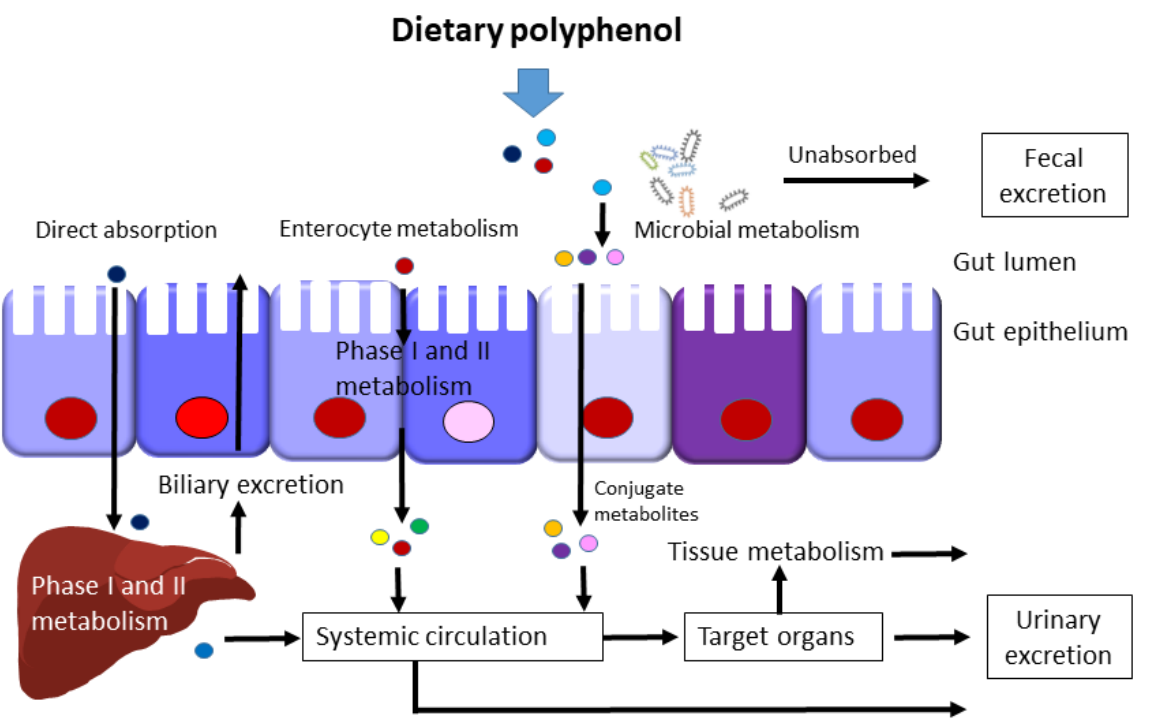
Figure 2. Metabolic fate of dietary polyphenols in the body. Within the host, dietary polyphenols undergo phase I and II metabolism in liver and gut, microbial metabolism, absorption in systemic circulation, interaction with target organs, and elimination in feces and urine.